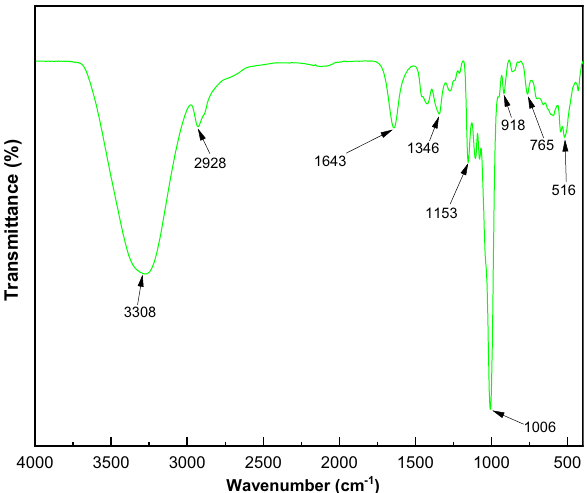
Figure 10. FT-IR spectra of the examined PGA using ATIR.